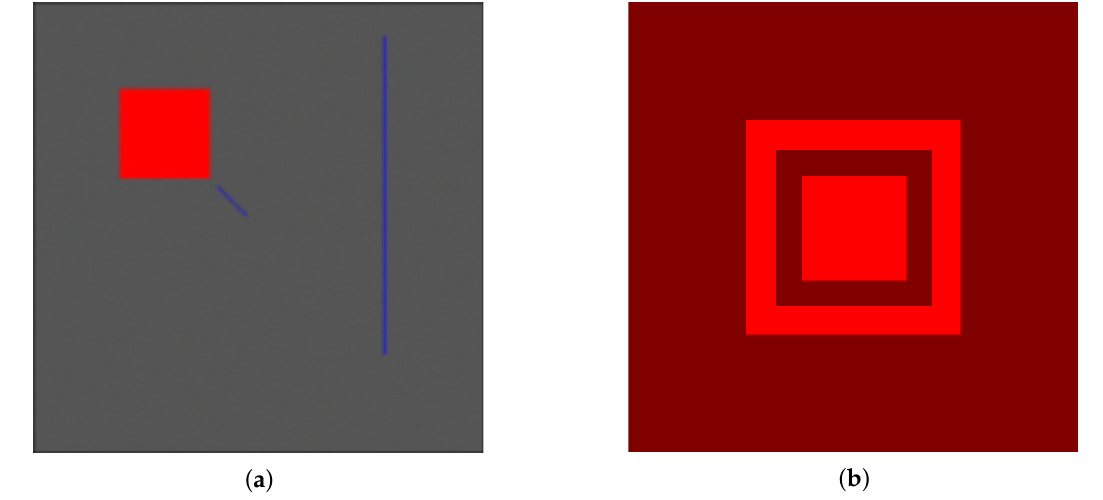
Figure 4. ( a ) a simple RGB image with a red square and a couple of blue lines. The red coordinates are ( 1,0,0 ) (cid:62) in the RGB space, while the lines’s coordinates are ( 0,0,1 ) (cid:62) . The background value is constant and set to 1/3 on all channels. A 7 Gaussian PSF with unitary variance blurs the whole image, and Gaussian noise at level 0.1 is added to each channel. ( b ) a red square surrounded by frames; one of the frame has the same colour coordinates for the inner square, the other two frames share the same